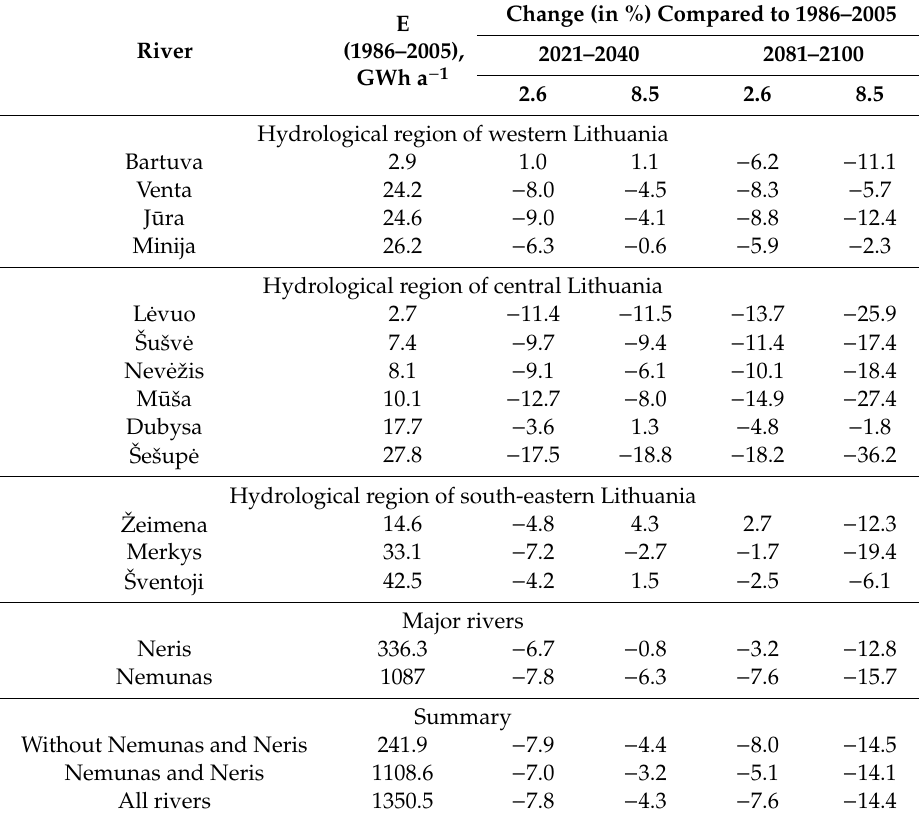
Table 5. Kinetic resources of the main Lithuanian rivers (E KT , GWh a − 1 ) and projection of their changes (in %) in the near and far future relative to 1986–2005.